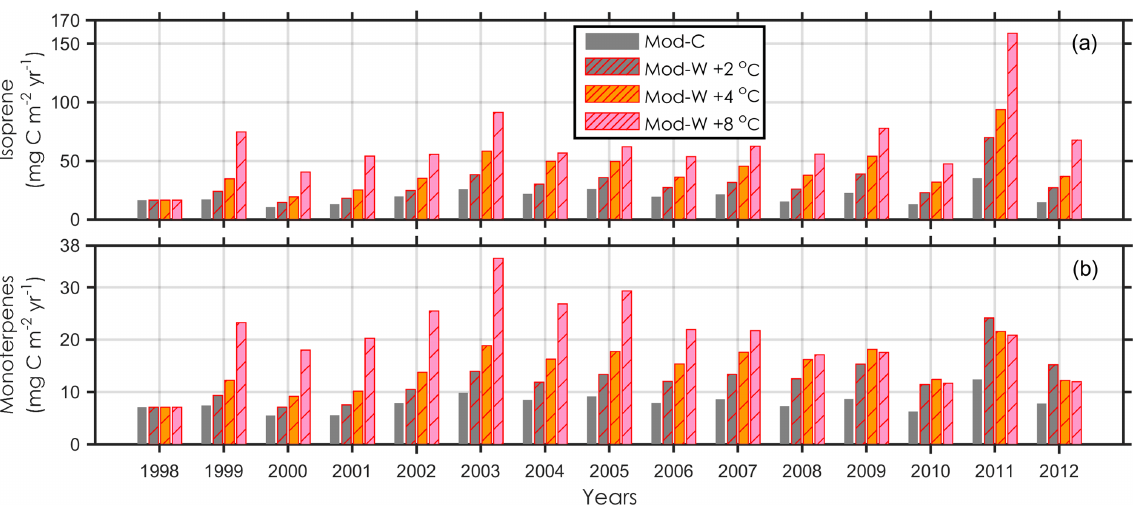
Figure 6. Modelled annual isoprene and monoterpene emissions for the period 1998–2012 at the Abisko heath tundra. The warming (W) treatment started in 1999 and three levels of warming ( + 2, + 4 and + 8 ◦ C) were applied during summertime. The modelled annual emissions in the control (C) plots are also